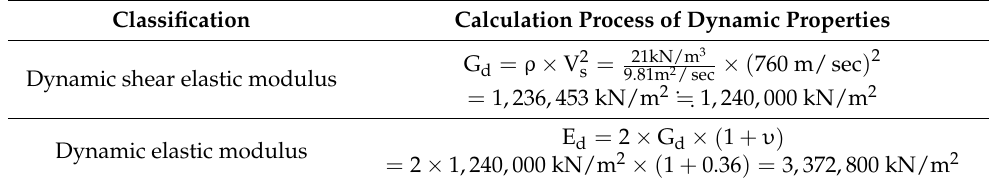
Table 5. Calculation process of dynamic